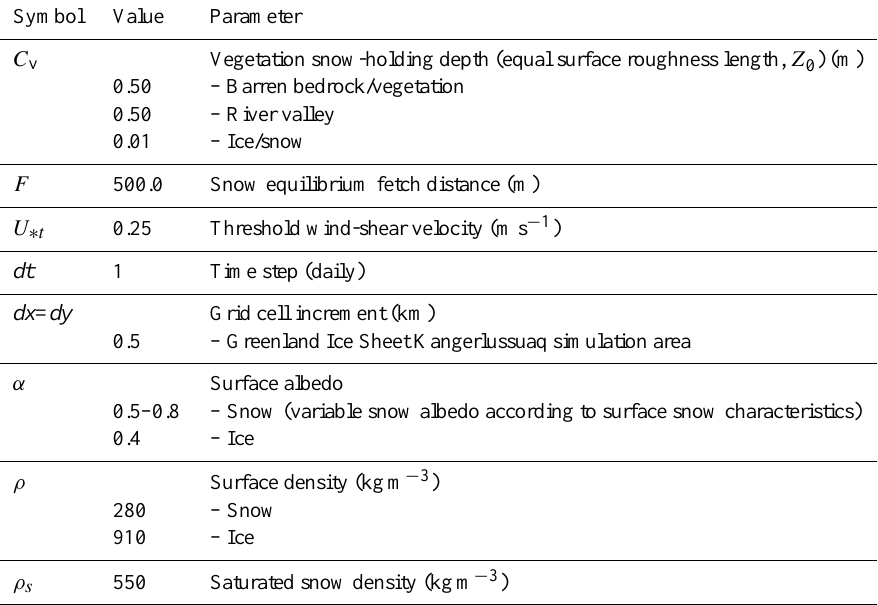
Table 2. User-defined constants used in the SnowModel simulations (see Liston and Sturm, 1998, for parameter definitions). Symbol Value Parameter C v Vegetation snow-holding depth (equal surface roughness length, Z 0 ) (m)